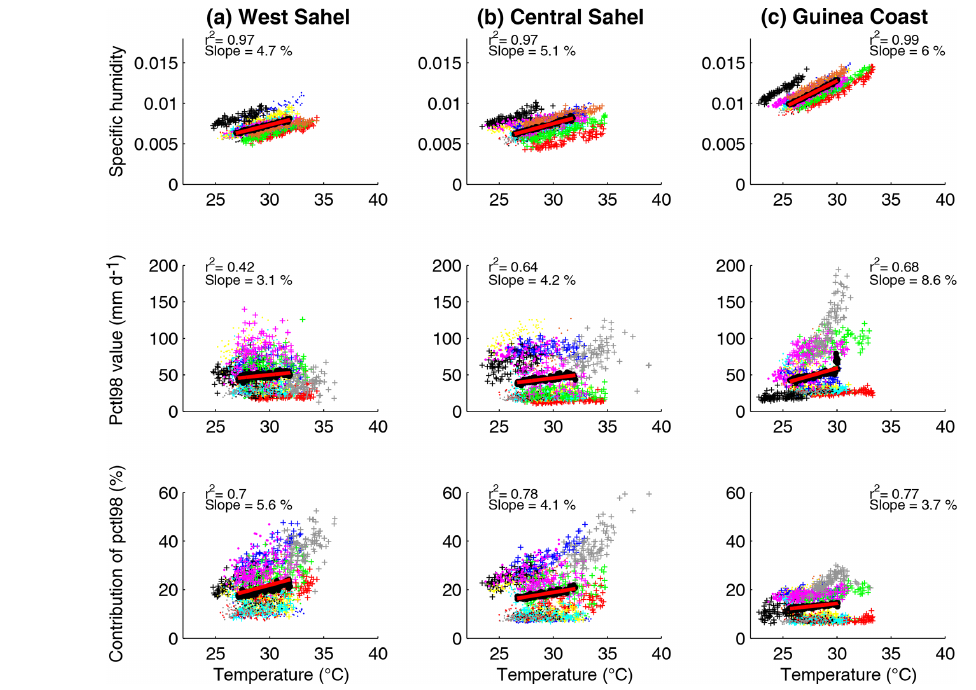
Figure 5. Annual values of specific humidity, 98th percentile (mmd − 1 ), and contribution of precipitation above the 98th percentile (%) ( y axis) shown against annual mean temperature ( ◦ C) ( x axis), and averaged over (a) West Sahel, (b) Central Sahel, and (c) Guinea Coast. Each color corresponds to a single simulation, as described in Table 1, and the thick black dots correspond to the multimodel mean. Also shown are the fitted regression line of the multimodel mean (red line) and the associated coefficient of determination (“ r 2 ”) and correlation (“slope”, in % ◦ C − 1 , as compared to the 2006–2100 mean value). Note that specific humidity for the model NCC-NorESM1-HIRHAM5 was not available to download at the time of the